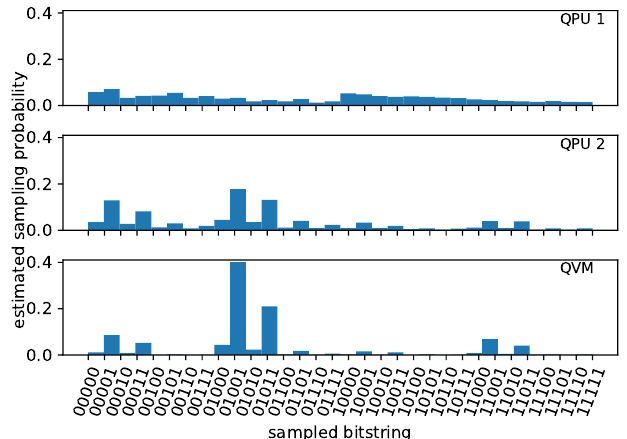
Figure 8: A typical instance of QAOA-circuit optimized probability distributions of the measured qubit bitstring output. We compare the result for IBM Q devices: ibmq_london (TOP) and ibmq_athens (MID) versus the qiskit shot-based simu- lator (BOTTOM), for the same problem instance for a total of 10240 shots. This figure represents data from an experiment done in Section